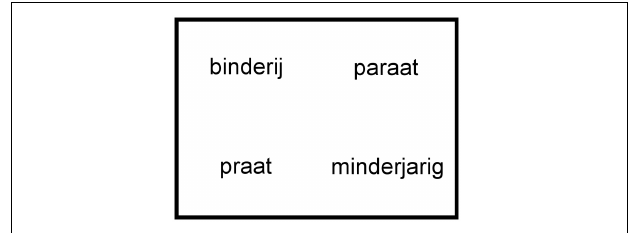
FIGURE 1 | Example display of a test trial in Experiments